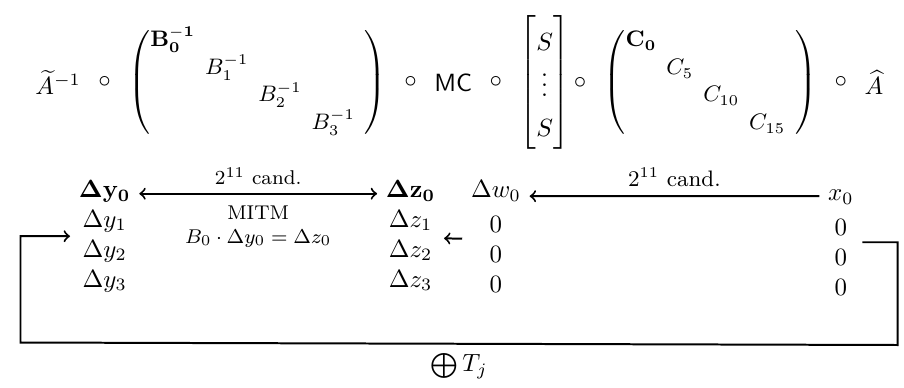
Figure 4: Identifying correct